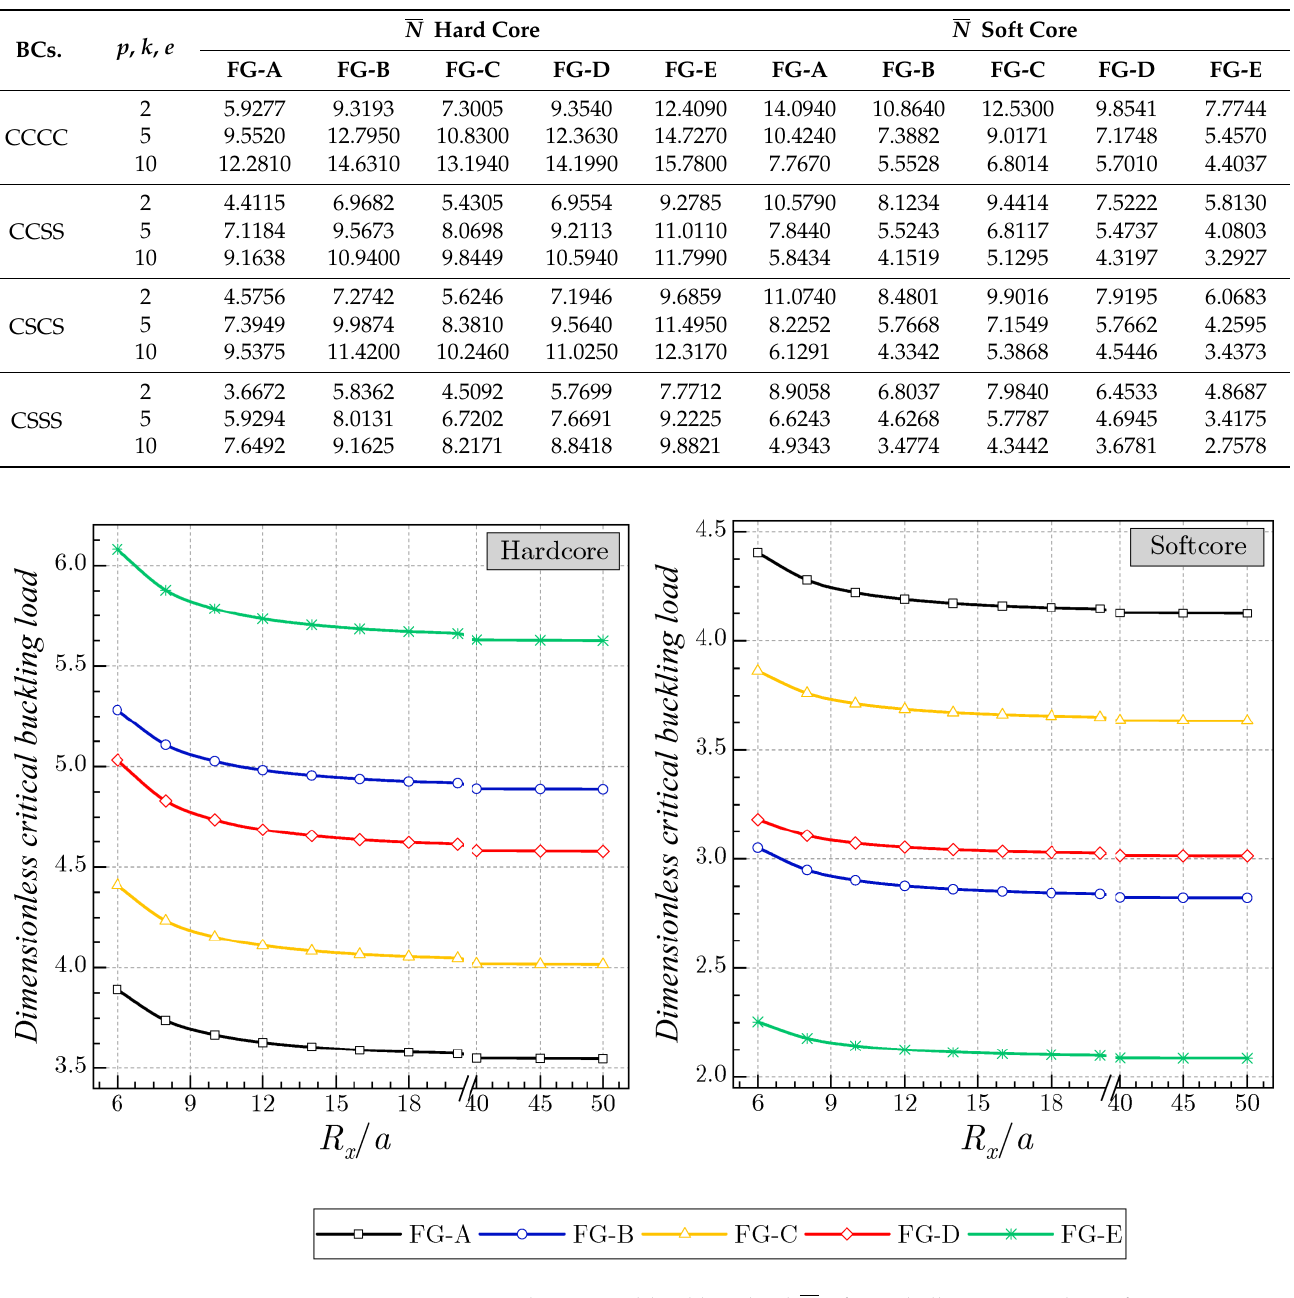
(cid:1) = 𝐺 = 𝐾 = 0) . 𝜁 𝜂 𝑤